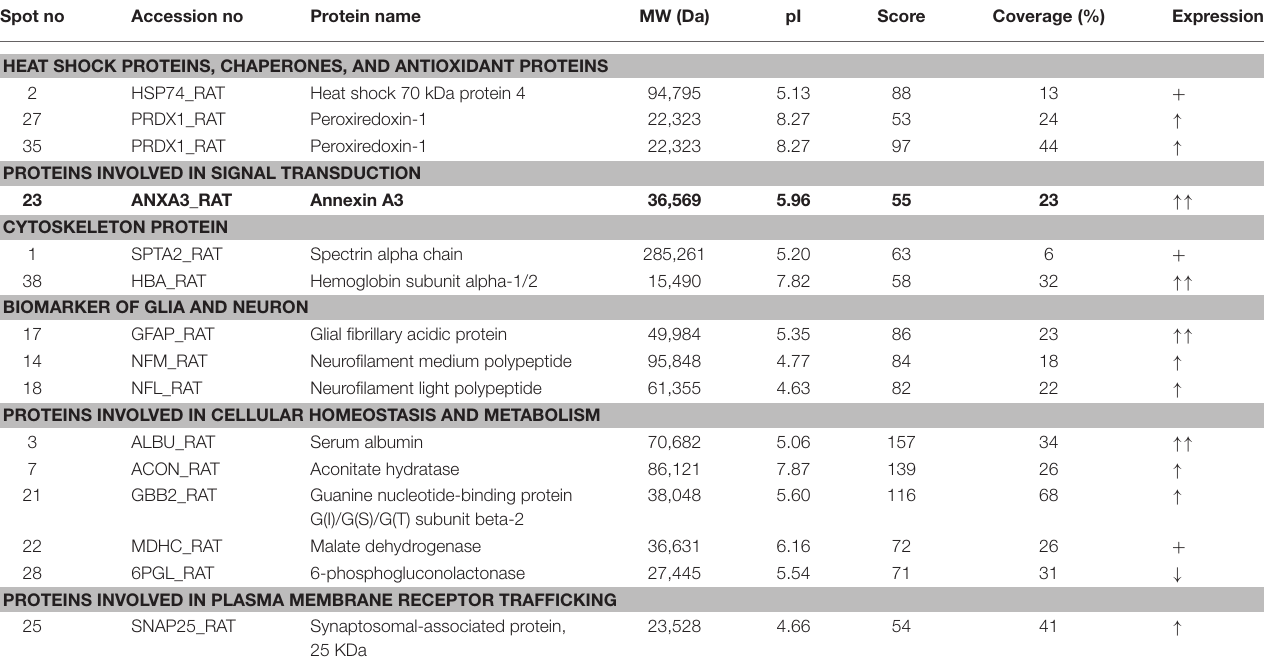
Up-arrows = upregulated. Down-arrows = downregulated. 2DGE of each group was done in triplicate. (n = 4 animals per group). Plus sign = New DPEs in the CCI-NP rats. Bold values mean to highlight the classification of DEPs and to highlight Annexin A3.